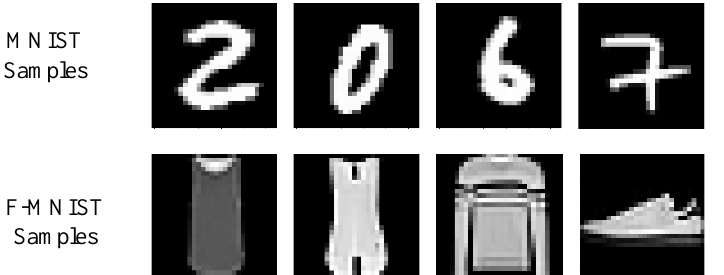
Figure 4. Samples of the MNIST and F-MNIST datasets.